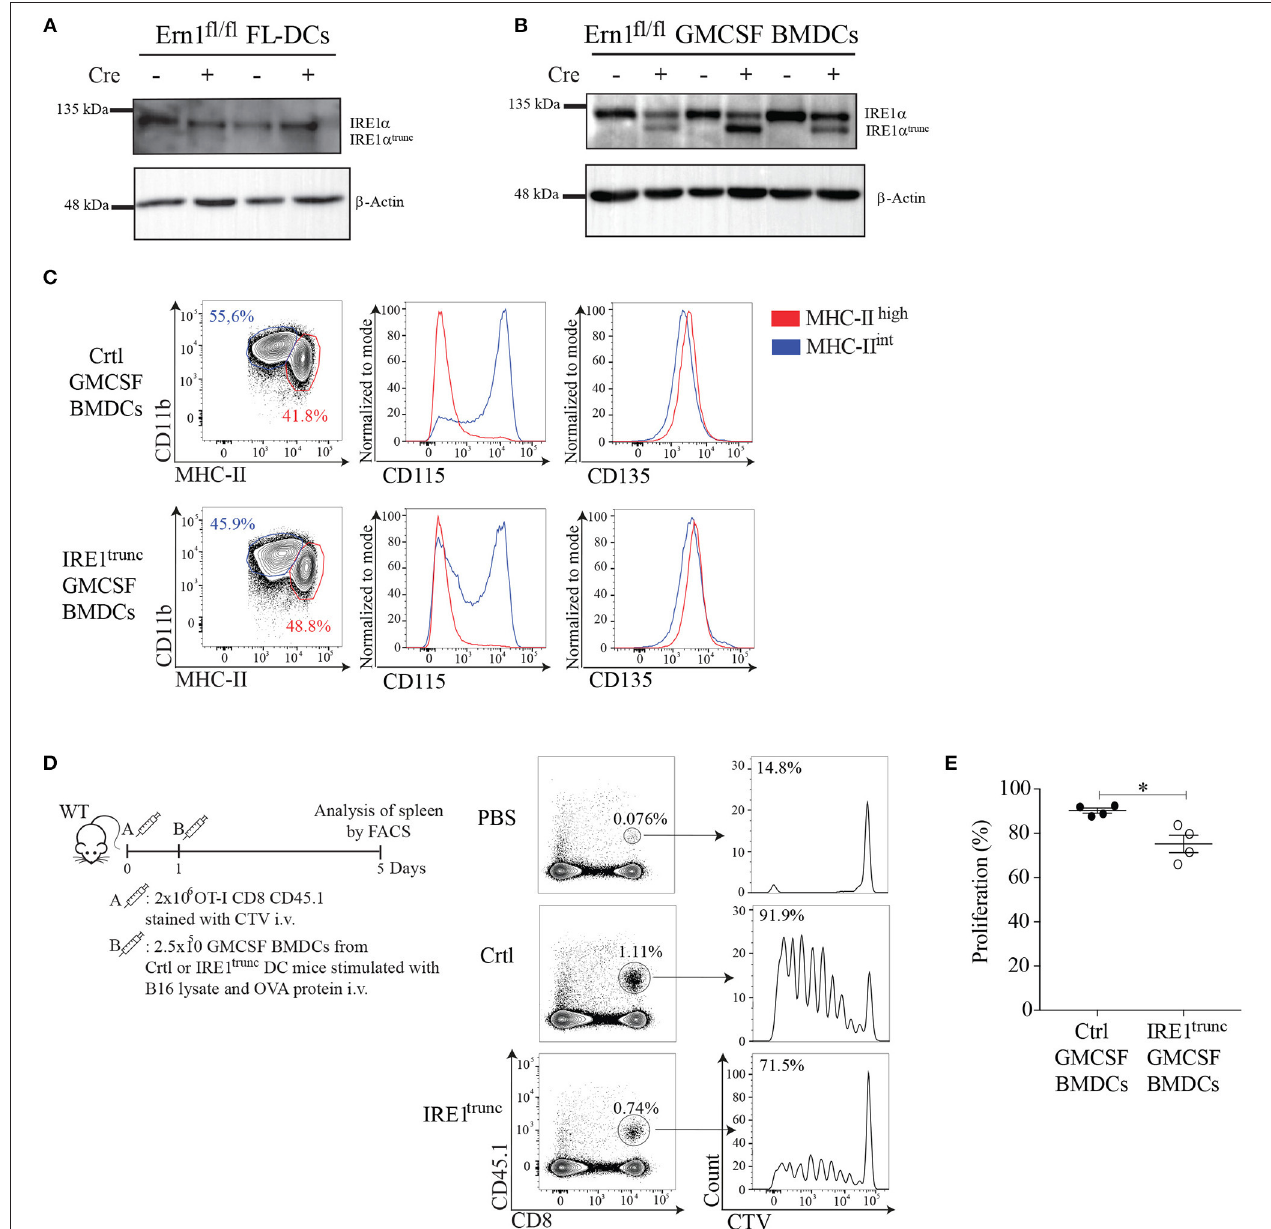
FIGURE 6 | IRE1 α endonuclease activity in GMCSF-BMDCs promotes cross-presentation of tumor-associated antigens in vivo. (A,B) Western Blot analysis of IRE1 levels in FL-DCs and GMCSF BMDCs of IRE1 trunc or ctrl DC mice. (C) Phenotype of GMCSF BMDCs from IRE1 trunc or ctrl DC mice at day 8 of culture (gate on CD11c + cells). (D) In vivo proliferation of OT-I CD8T cells (CD45.1 + ). 2 × 10 6 CD8T cells stained with CellTrace Violet (CTV) were adoptively transferred into congenic mice. One day later mice were injected i.v. with 2.5 × 10 5 GMCSF BMDCs, from IRE1 trunc or ctrl DC mice pulsed with 100 µ g/ml B16 lysate plus 200 µ g/ml OVA. Histograms represent the proliferation of transferred cells (CD8 + CD45.1 + ) in the spleen. (E) The graph represents the percentage of proliferation of CellTrace Violet-labeled cells. Each symbol in the graph represents data from an individual mouse. Error bars represent mean ± S.E.M. * p < 0.05 determined by Mann–Whitney